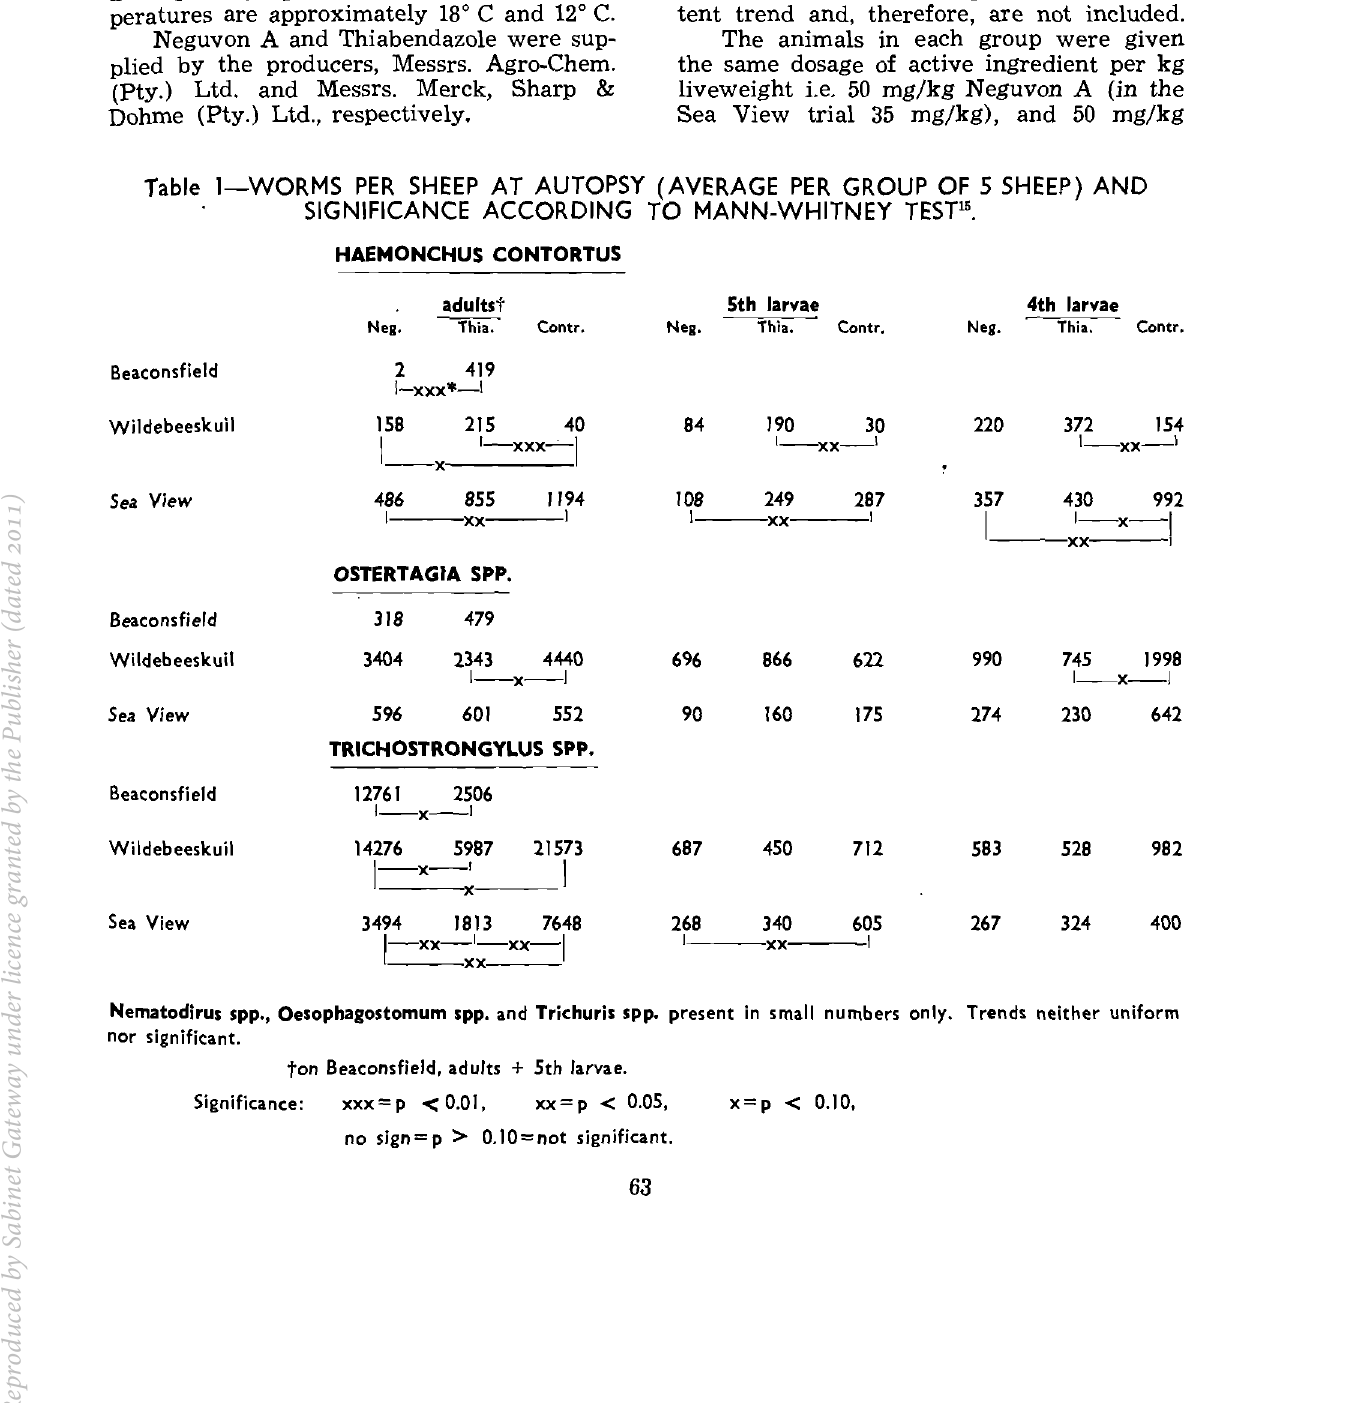
Table I-WORMS PER SHEEP AT AUTOPSY (AVERAGE PER GROUP OF 5 SHEEP) AND . SIGNIFICANCE ACCORDING TO MANN-WHITNEY